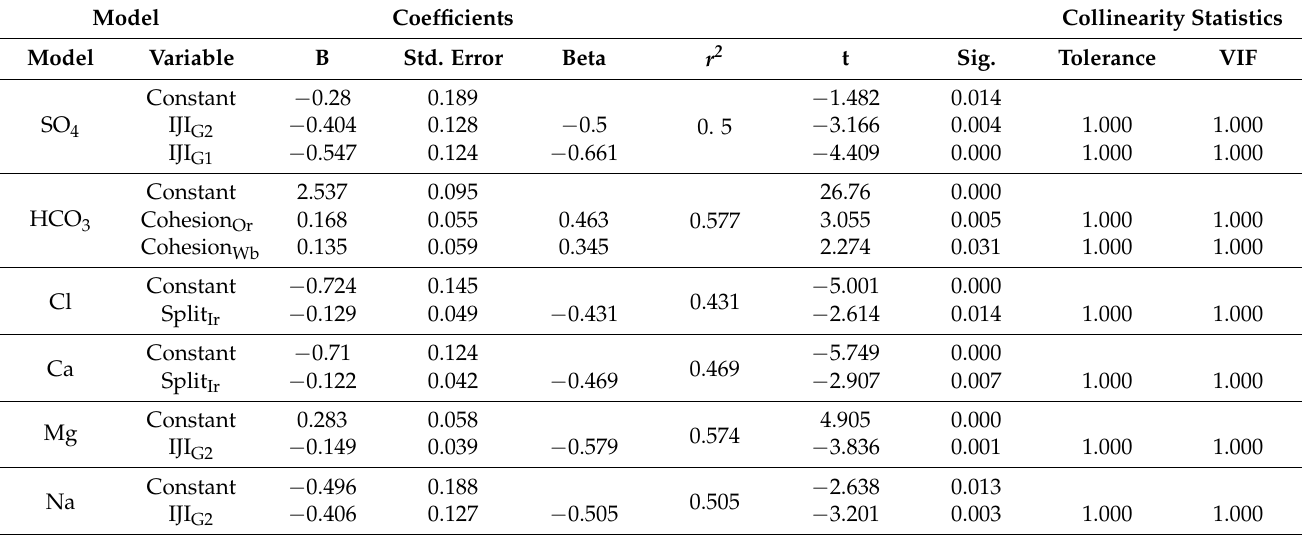
Table 5. Details of the regression models of the water quality